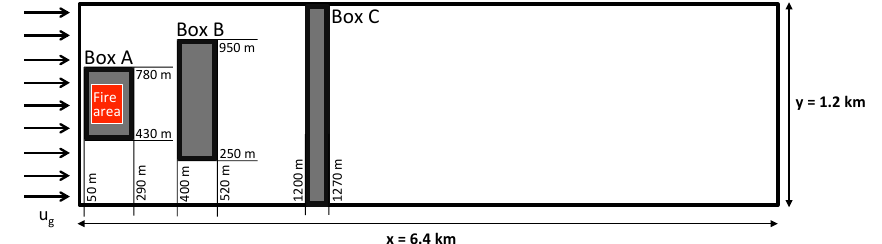
Figure 2. Schematic view of the x – y plane of the model domain. Three areas with different distances from the fire area are marked (boxes A, B, C). Each box has a base size of 84000m 2 (figure not true to